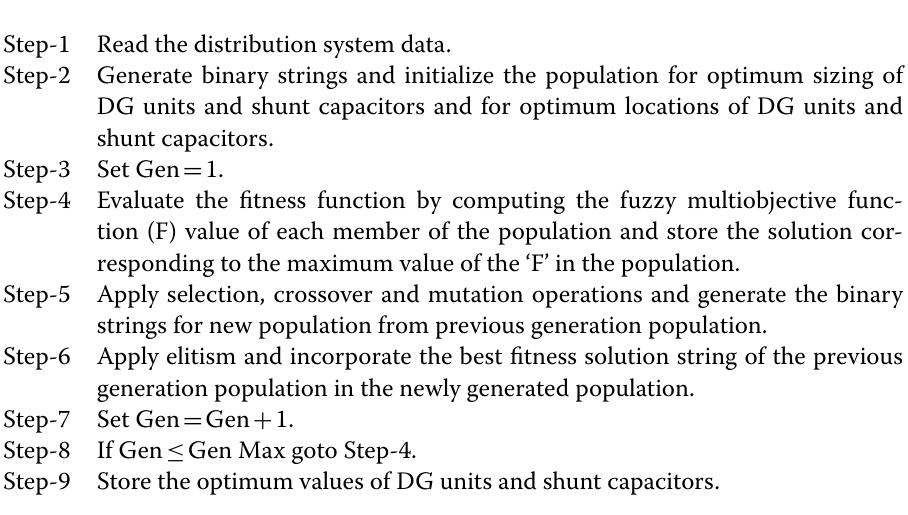
Fuzzy GA algorithm for simultaneous optimum placement of DGs and shunt capacitors The fuzzy GA-based algorithm for optimization of simultaneous optimization of DG